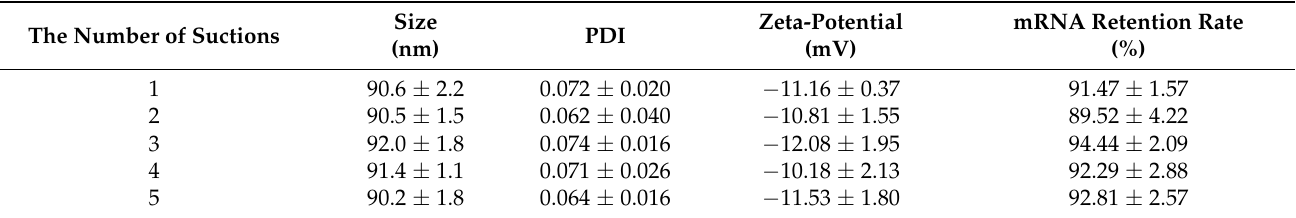
Table 6. Effects of the suction from the vials on particle properties of the mRNA encapsulating